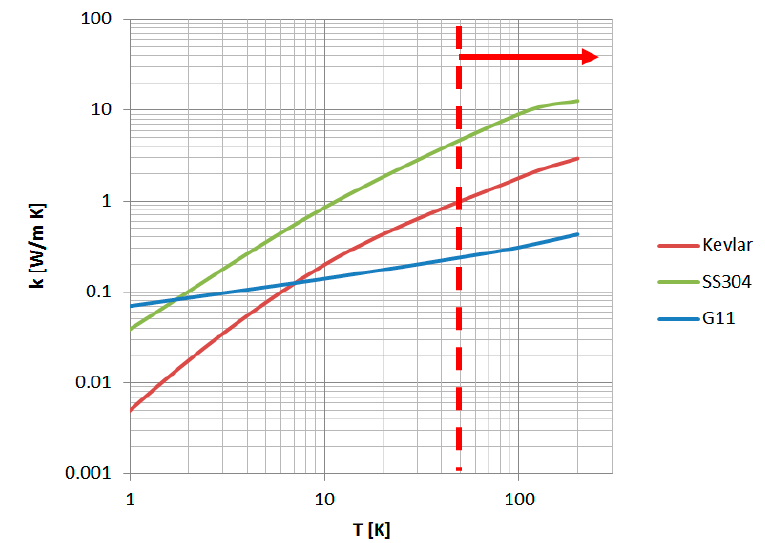
Figure 11. Thermal conductivity of various materials used for cryogenic support and range on thermal shield (TS) support temperatures. Red line shows the operational temperature range.